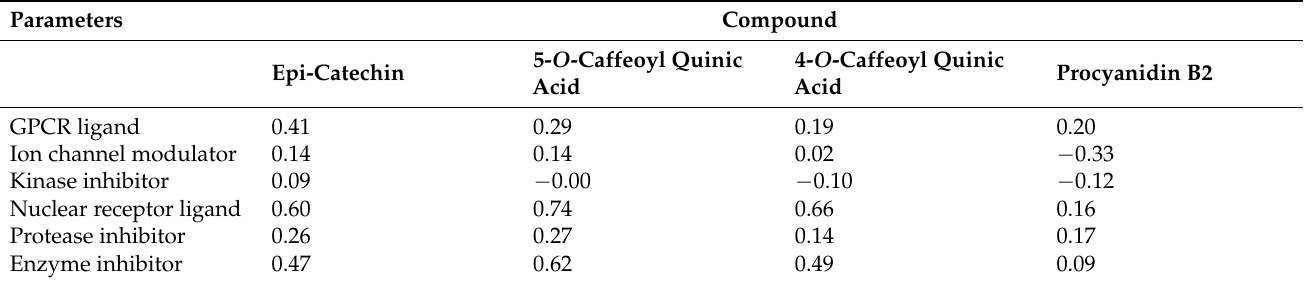
Table 3. Bioactivity score of compounds isolated from BK(B).